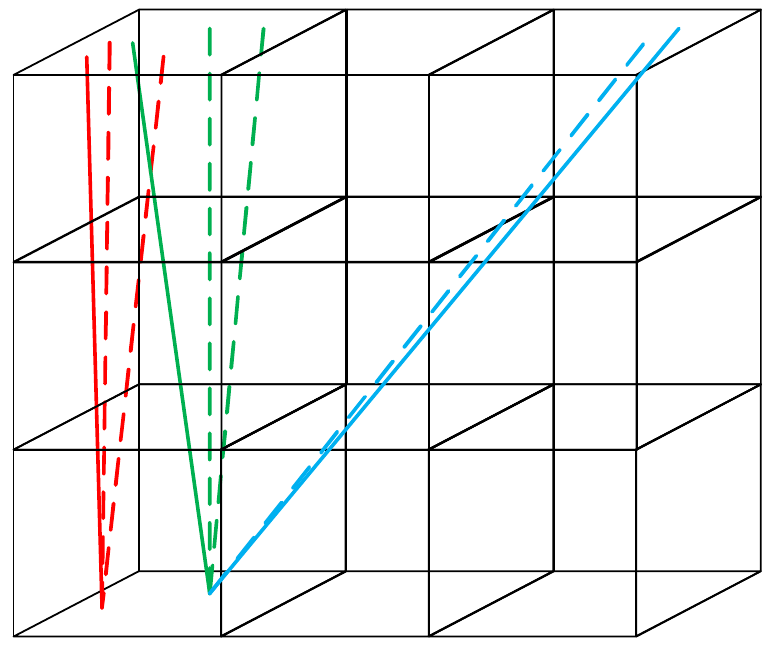
Figure 4. Redundancy of two types of valid signals.